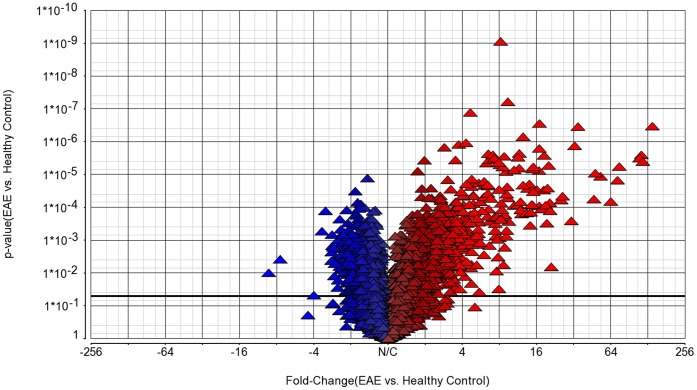
Volcano plot.This shows the significance (y axis) versus the fold change (x axis) for genes in rats with EAE compared to healthy controls.